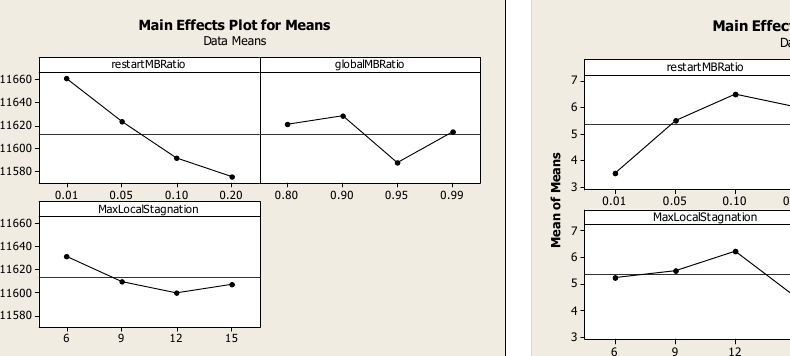
Fig. 16. The output of MINITAB for the average best solution through the DMSA algorithm